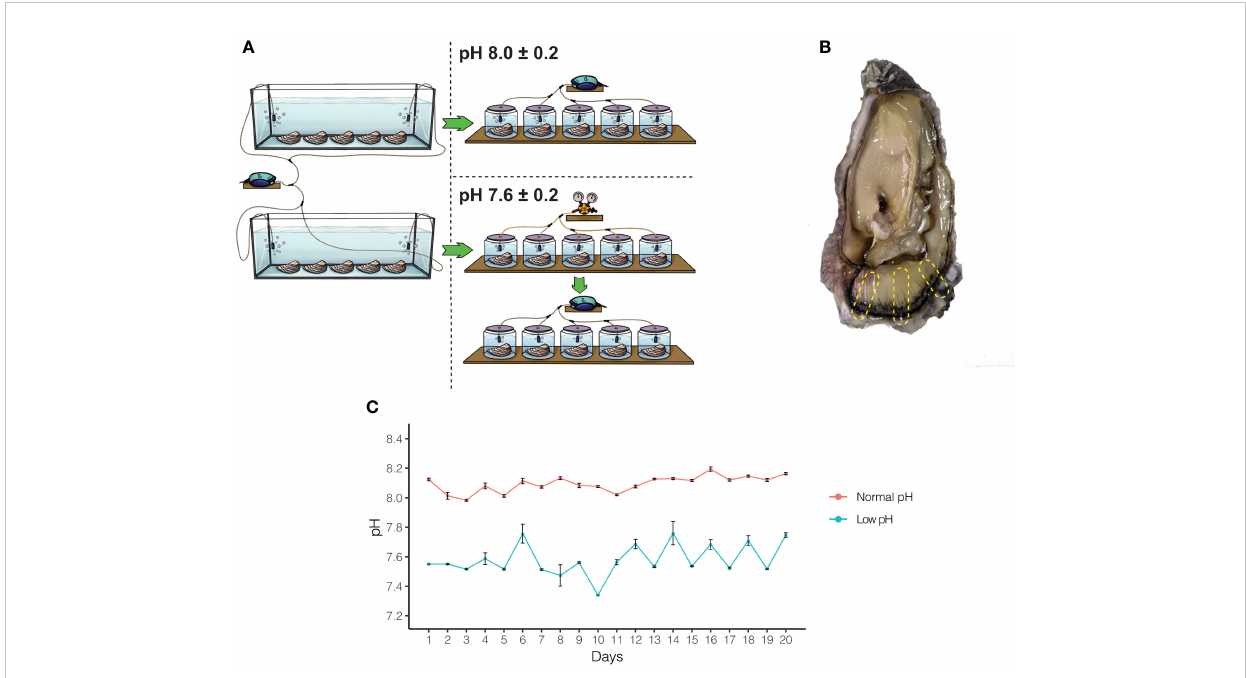
FIGURE 1 Experimental design and pH measurement to study the effect of OA on adult oysters. (A) A total of ten oysters were acclimated for two weeks and then split into two experimental treatments. After acclimation, fi ve oysters were kept under normal pH (8.0 ± 0.2) and low pH (7.6 ± 0.2) conditions for 20 days. (B) After the experimental period, oysters were sacri fi ced, and different regions of the mantle tissue were removed to conduct histological and transcriptome analyses. (C) pH on each experimental fl ask was measured three times daily for 20